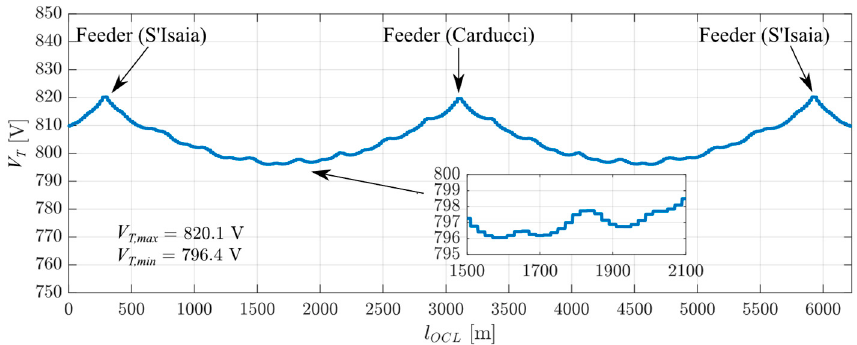
Figure 8. OCL voltage sensed by the trolleybus traveling along FS 1.